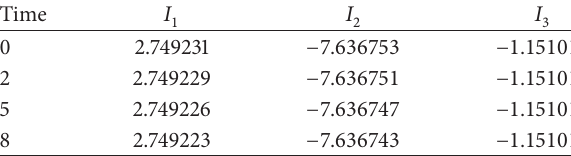
Table 2: Conservative